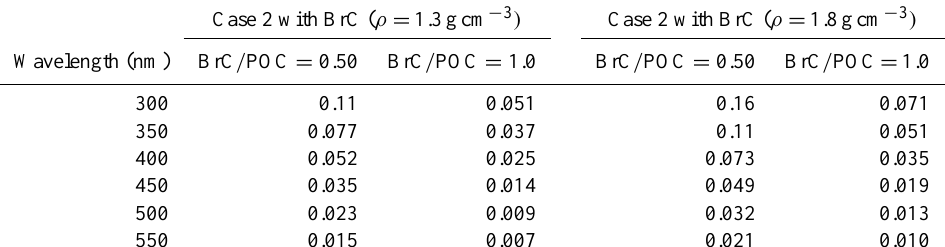
Table 5. Imaginary part of the refractive index ( k) values for brown carbon (not total organic carbon) inferred for case 2. We include k values associated with multiple densities ( ρ) , and multiple fractions of brown carbon to primary organic carbon (BrC / POC). All four columns for case 2 yield the same absorption.